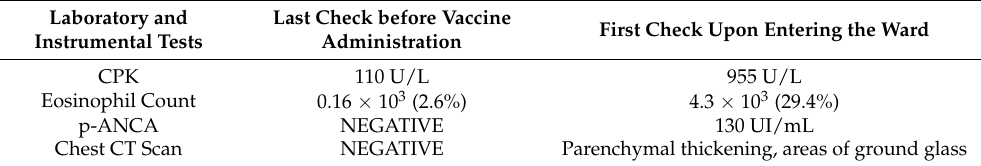
Table 1. Principal clinical features before and after Vaccine